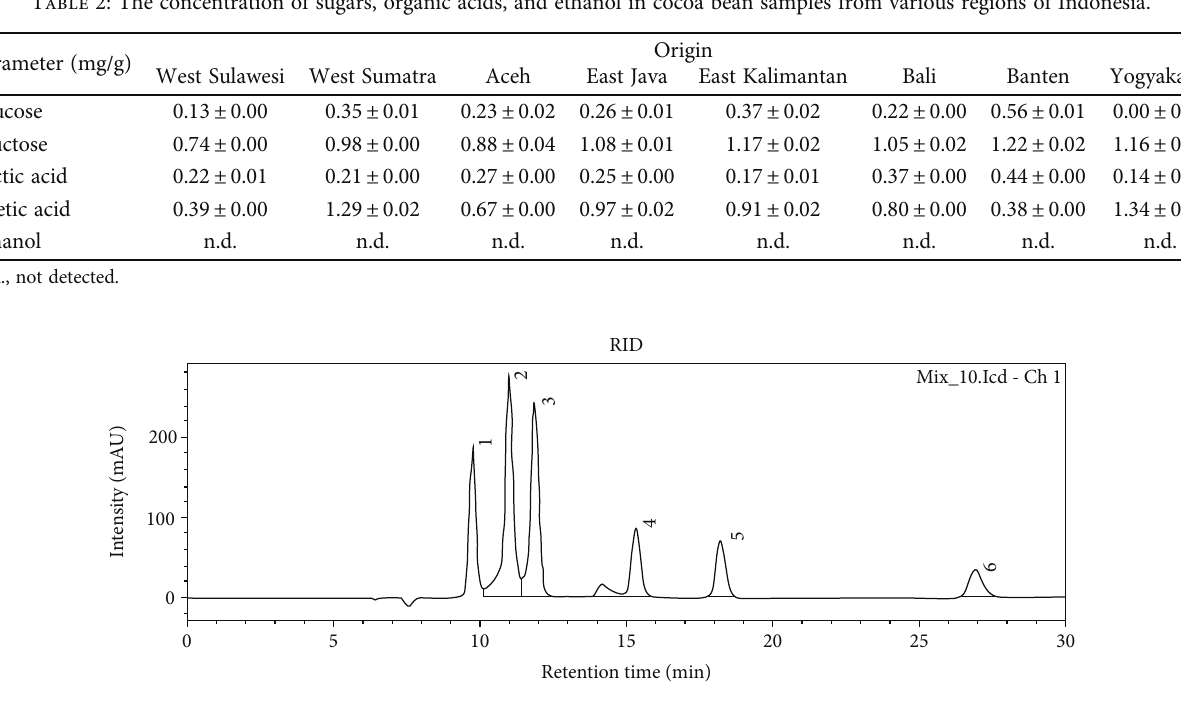
Figure 3: HPLC chromatogram of standards: (1) citric acid, (2) glucose, (3) fructose, (4) lactic acid, (5) acetic acid, and (6) ethanol.